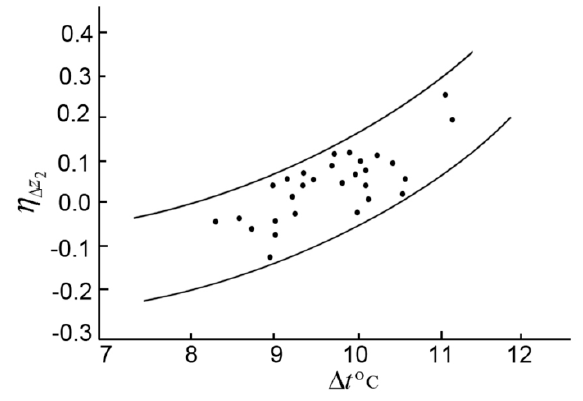
Figure 10. The relationship between ∆ t and η ∆ z